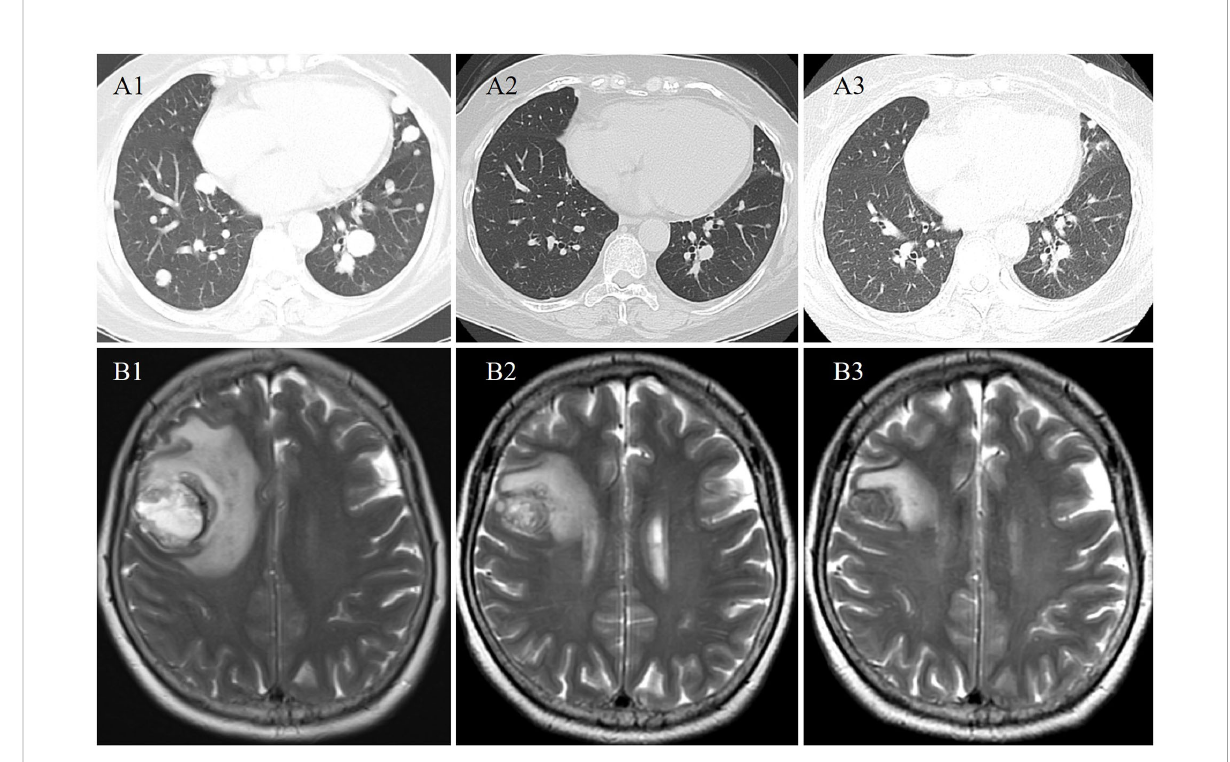
FIGURE 2 Radiological evaluation at baseline (A1 and B1), 1 (A2 and B2), and 3 (A3 and B3) months from start of alectinib therapy demonstrating an ongoing partial response in the pulmonary and brain